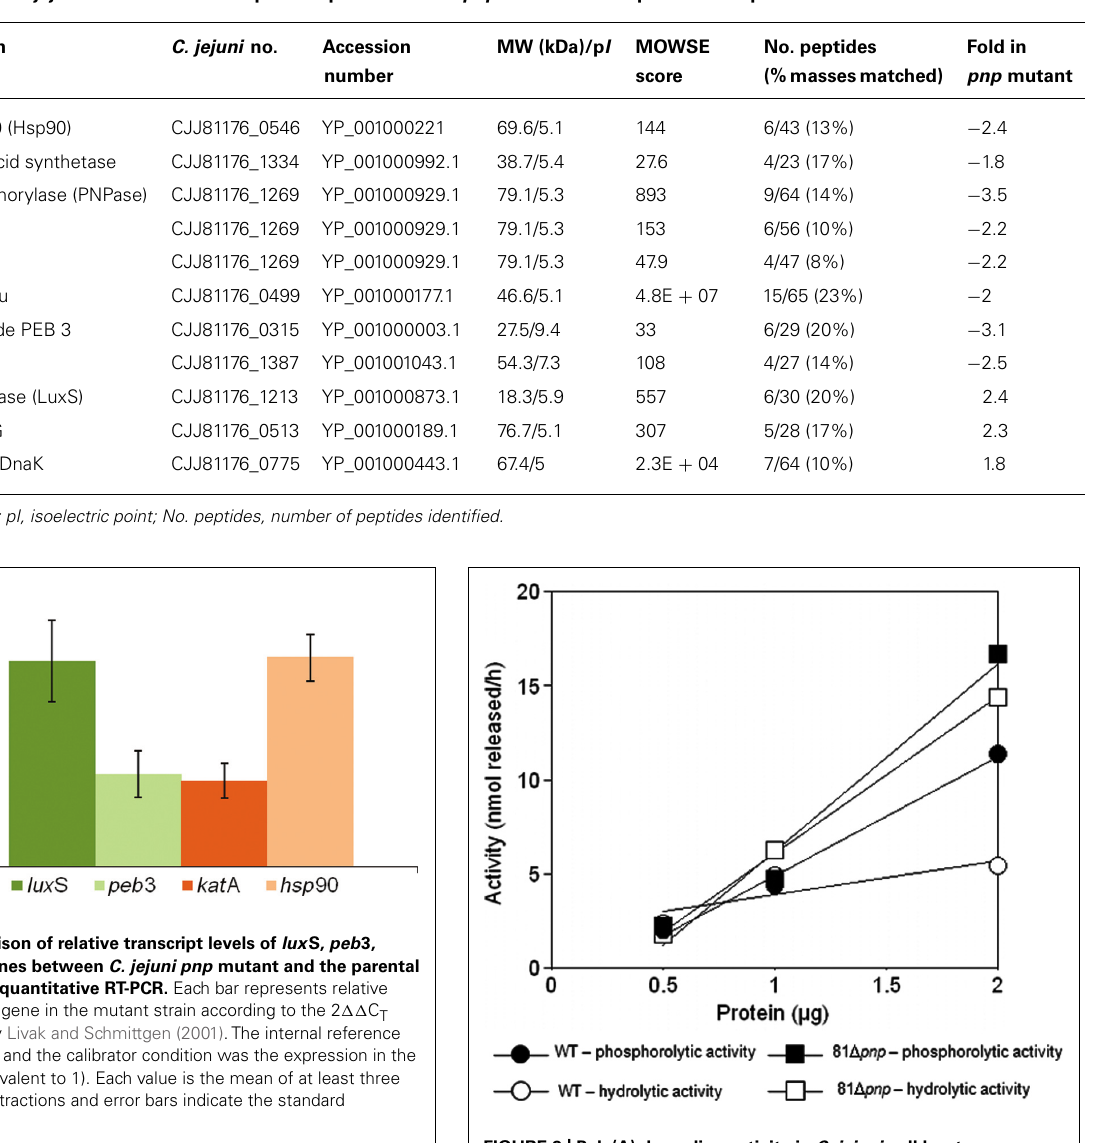
FIGURE 8 | Poly(A) degrading activity in C. jejuni cell lysates. Degradation of [ 3 H]poly(A) was quantified by scintillation counting [ 3 H]nucleotide released into acid soluble form. Dependence of the reaction on lysates of the parental strain (circle) and the pnp mutant (square) was measured in the presence (closed) and absence (open) of 10 mM KPO 4 to distinguish hydrolytic from phosphorolytic activities.